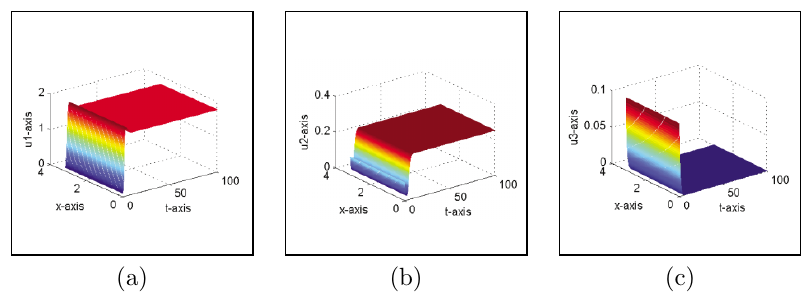
Figure 3. The time dependent solution found by numerical integration with r 1 = 2, r 2 = r 3 = 1, a 11 = a 12 = a 21 = 1, a 22 = 3, a 23 = a 32 = a 33 = 1, d 1 = 1, d 2 = 2, d 3 = 1, τ 1 = τ 2 = 0 . 1; φ i ( x, 0) = 0 . 1 ( i = 1 , 2 , 3); ∂u i /∂x = 0 ( i = 1 , 2 , 3), t ≥ 0, x = 0 ,π